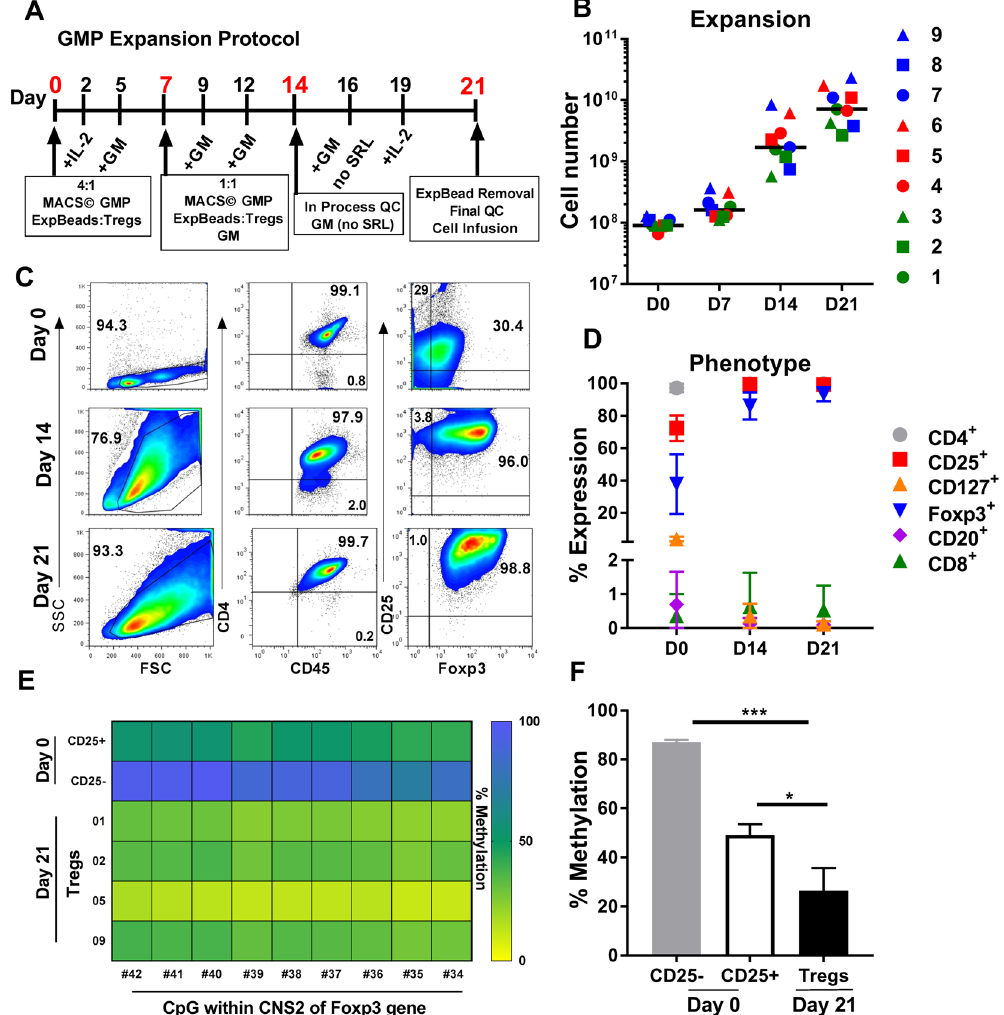
Figure 2. Expansion and Profile of nine expanded Treg products: ( A ) Outline of clinical good manufacturing expansion protocol established at the Mathews Center for Cellular Therapy, Northwestern Memorial Hospital. ( B ) Absolute cell number of all nine Treg products throughout expansion protocol; black bar represents grand median of all products (n = 9). ( C ) Representative clinical phenotyping of Treg products, specifically CD4 + CD25 + FOXP3 + expression on post CD25 enrichment (day 0) as well as days 14 and 21 of culture. ( D ) Represents the average ( ± SD) of expression of Treg markers CD4; CD25; and FOXP3; also non-Treg markers CD8, CD20, and CD127 throughout expansion protocol (n = 9). ( E ) Heat map of clinical Treg products and controls (day 0) depicting the percentage of methylation within 9 CpG sites of the conserved non-coding sequence 2 of FOXP3 gene in the expanded Tregs (TRK- 01–09; n = 4). (F) Average ( + SD) of the percent methylation in day 0 control products and day 21 expanded Treg products (n = 4). *** p < 0.005, * p < 0.05; GM = growth medium (described under